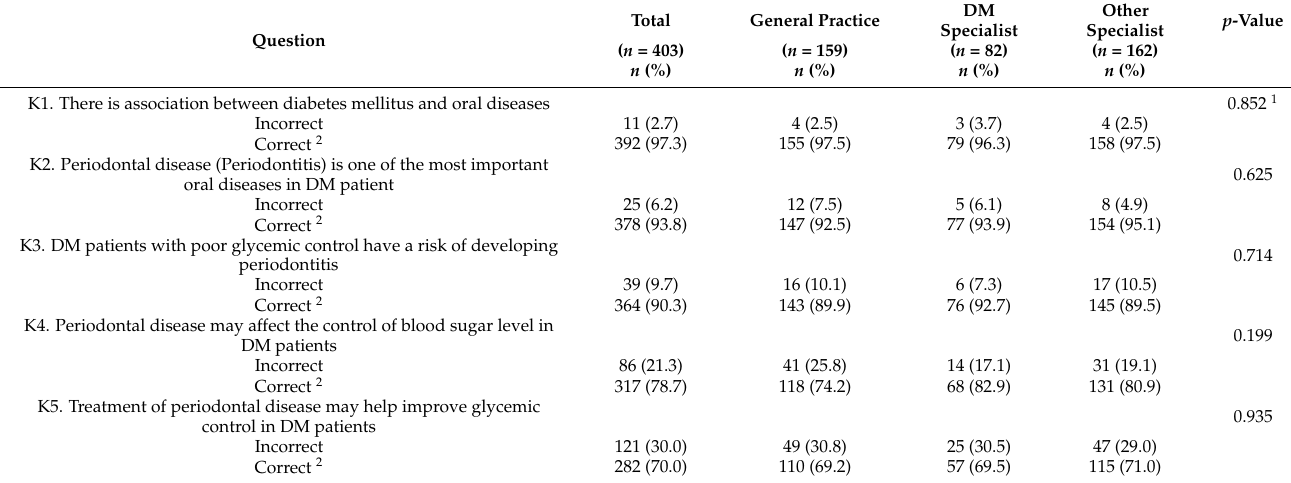
Table 2. Basic knowledge concerning association of diabetes mellitus and periodontal